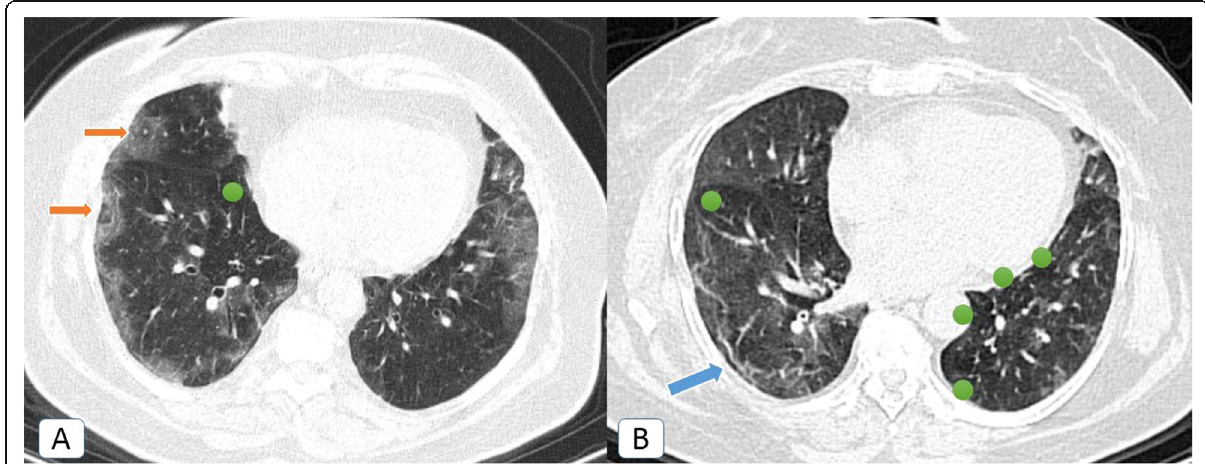
Fig. 5 COVID-19 infection atypically presented by head-cheese pattern (ground-glass attenuation alternating with air trapping): a 48-year-old female COVID-19 patient. A Initial axial chest CT (lung window) revealed multiple sub-pleural ground glass patches (orange arrows) of COVID-19 infection with a nearby medial basal area of air trapping (green circle) … “ Head-cheese pattern. ” B Follow up axial chest CT after 3 weeks (lung window) revealed healing of the ground-glass patches by curvilinear fibrotic bands (blue arrow) with persistent areas of air trapping